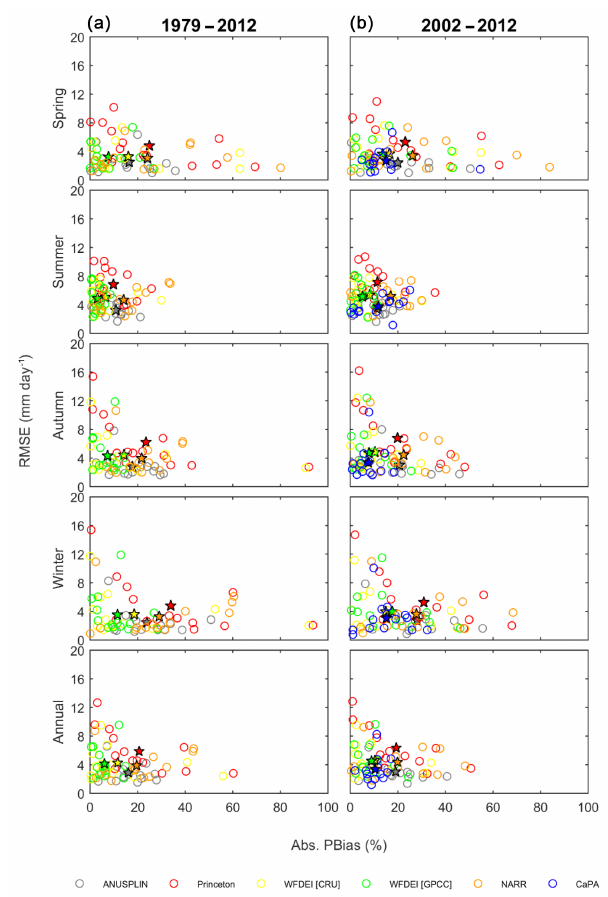
Figure 8. Scatter plots showing absolute P Bias ( x axis) versus RMSE ( y axis) of each precipitation dataset in four seasons and the entire year for the period of 1979 to 2012 (a) and 2002 to 2012 (b) . Each hollow circle represents one ecozone and the solid stars indi- cate the overall average across